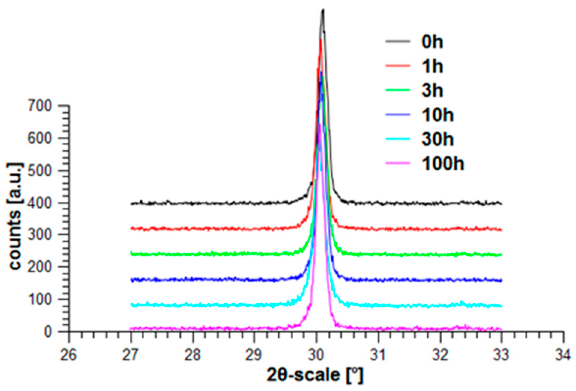
Figure 40. Hydrothermal treatment of ZCA10P (Ce-TZP/LaAl 11 O 18 ).